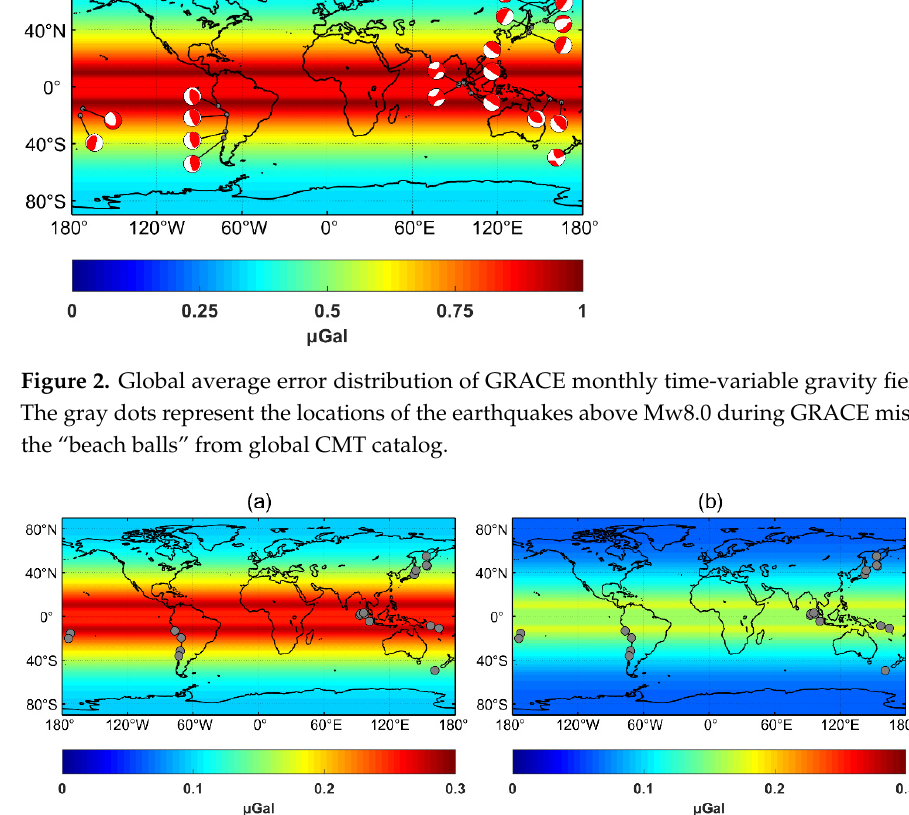
Figure 3. Global error distribution of stacking method in monthly models of GRACE ( a ) and GFO ( b ), respectively.